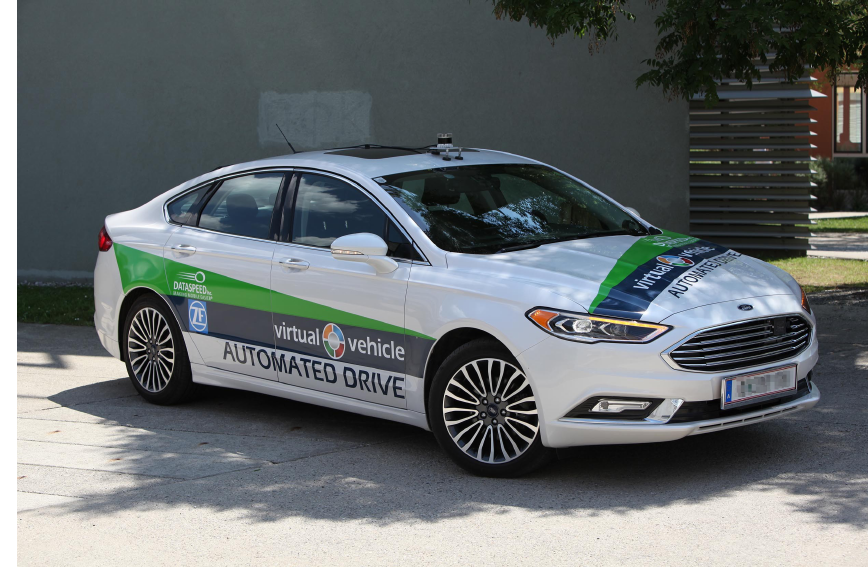
Figure 16. Virtual Vehicle Automated Drive Demonstrator